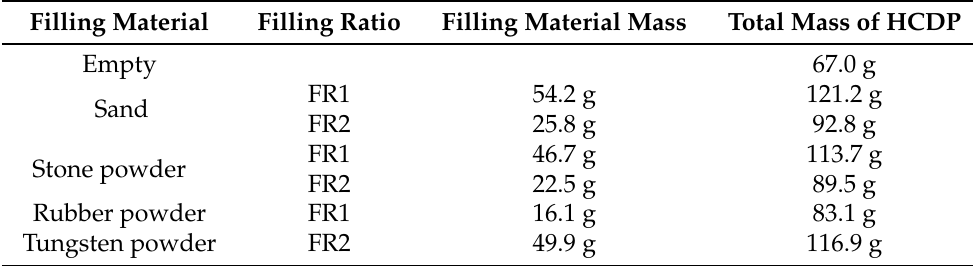
Table 2. List of filling materials, filling ratios (FR2 = 0.5 FR1), filling material mass and total mass of the